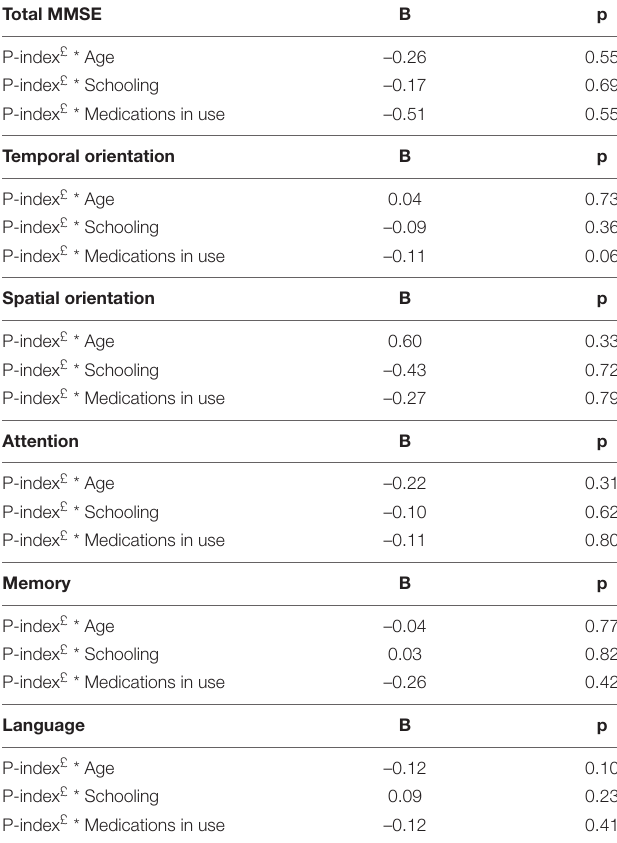
TABLE 4 | Interaction analyses to predict MMSE scores (total and